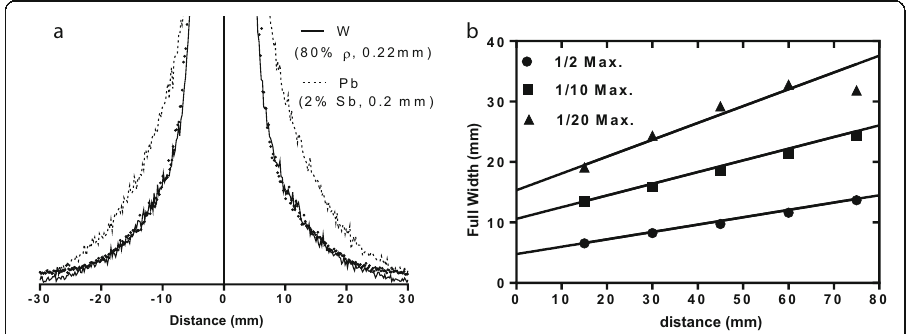
Fig. 13 Monte Carlo simulated line profiles of tungsten (80% ρ , 0.22 mm septa) and lead (25Sb, 0.2 mm septa) collimators ( a ) and comparison of measured (points) and simulated (solid line) (tungsten 80% ρ , 0.22 mm septa) resolution at different distances ( b